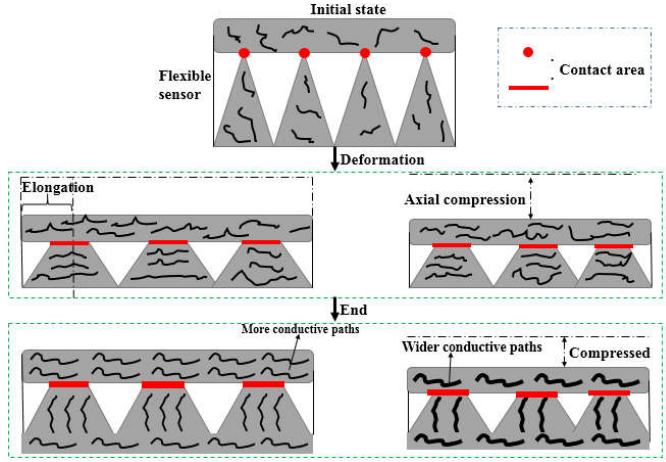
Figure 3. Schematic diagram of piezo-resistive properties of polymer-based flexible sensor.